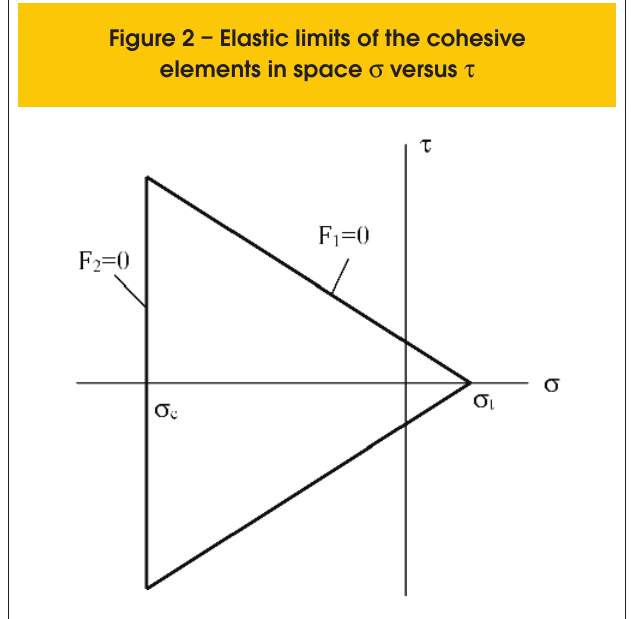
Figure 2 – Elastic limits of the cohesive elements in space s versus t